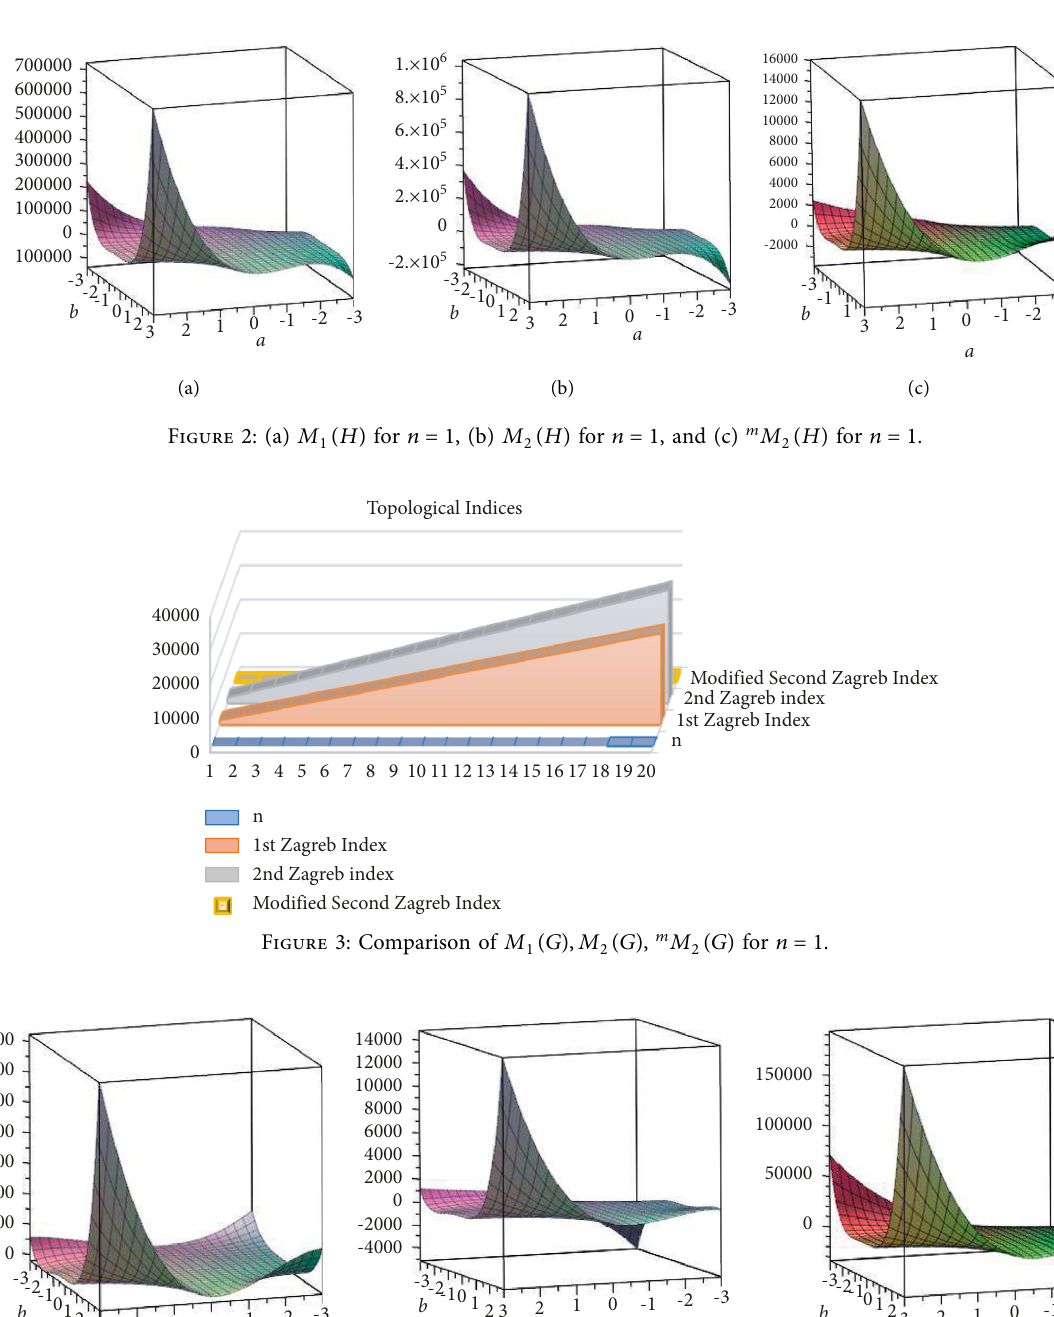
( H ) for n � 1 , α � 1, and (c) SDD ( H ) for n � 1. α